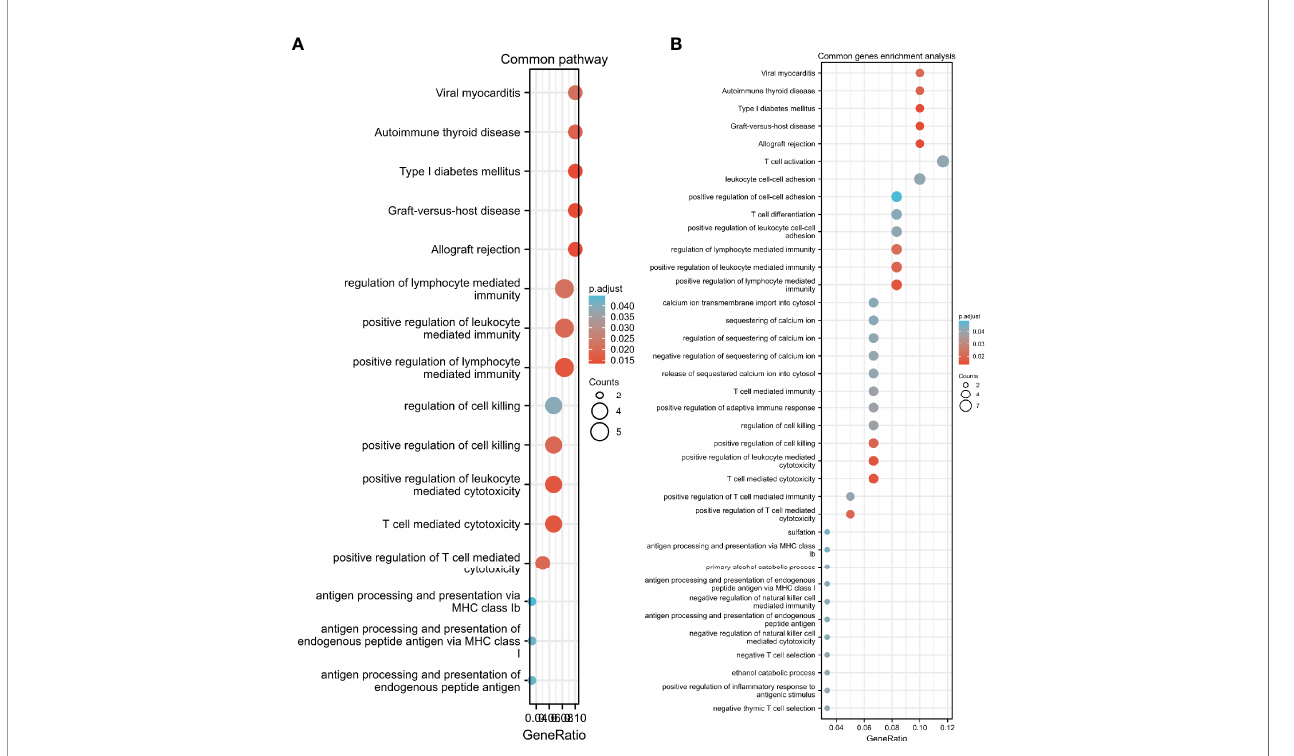
FIGURE 5 | GO term analysis network diagram for TWAS-identi fi ed genes, where each circular dot in the network represents a term whose size is proportional to the number of input genes for that term. (A) Common pathway; (B) Common genes enrichment